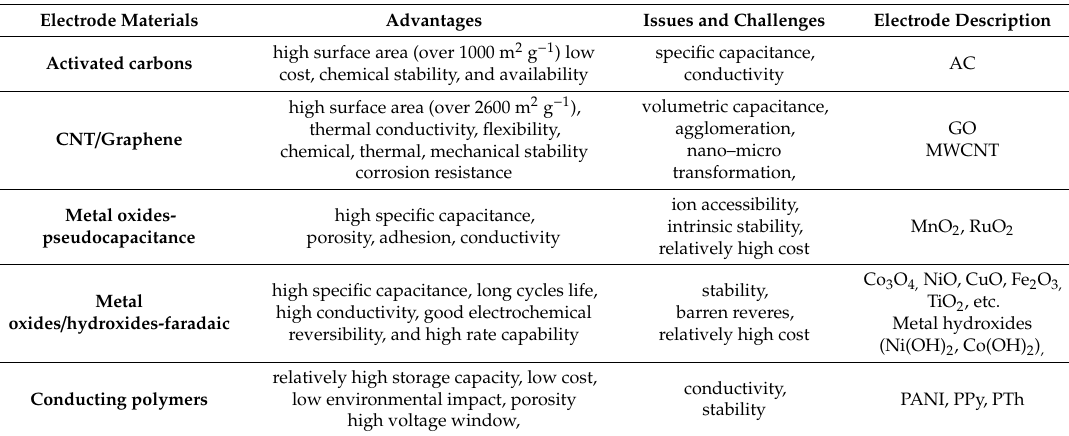
Table 2. Properties of various electrode materials